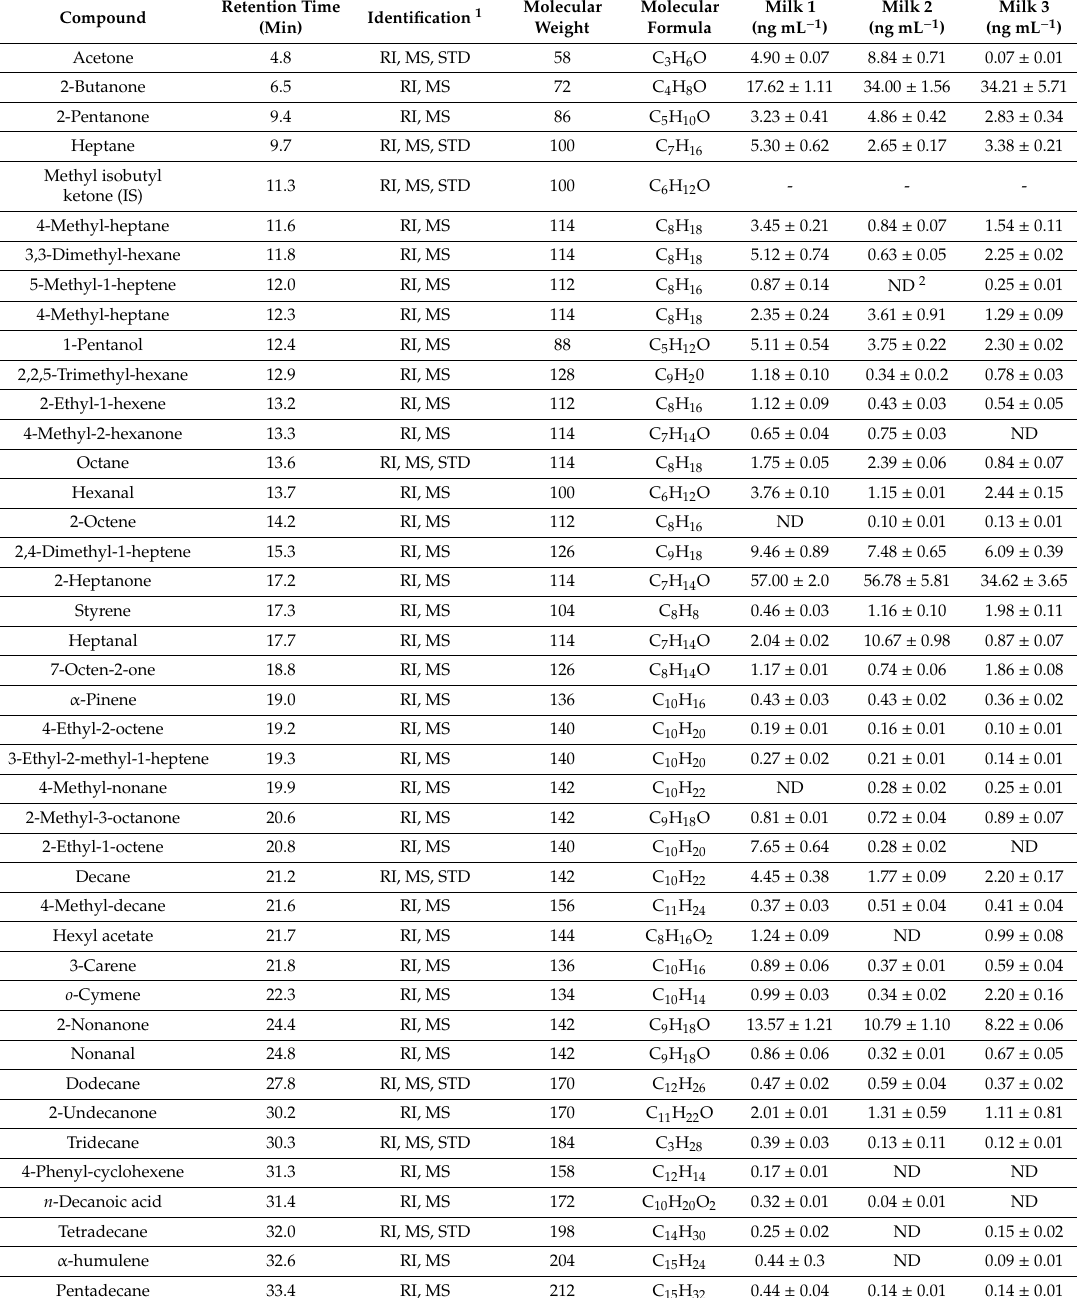
Table 1. Results from milk samples analysis with SPME